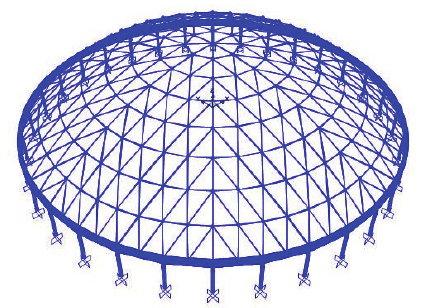
Figure 8: Finite element model of single-layer lattice